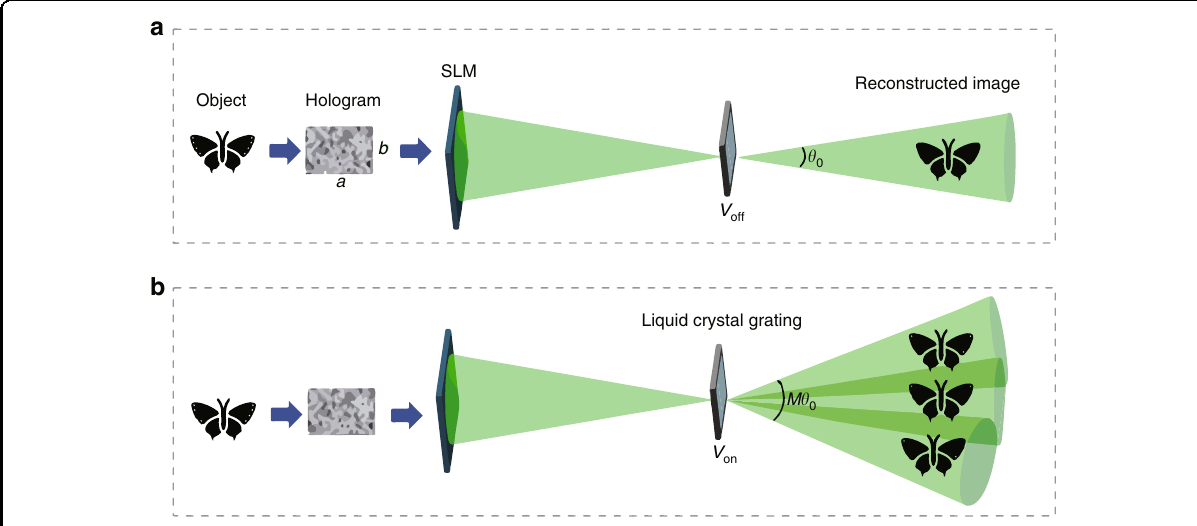
Fig. 4 Principle of the wide viewing angle holographic 3D display. a Viewing angle of the holographic display in the initial state. b Viewing angle when the voltage is applied to the tunable liquid crystal grating